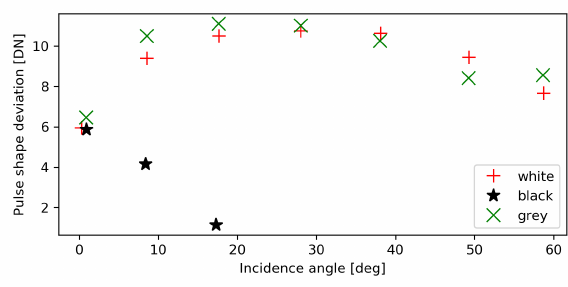
Figure 11. VZ-2000i deviation vs. incidence angle for a constant range of 60m